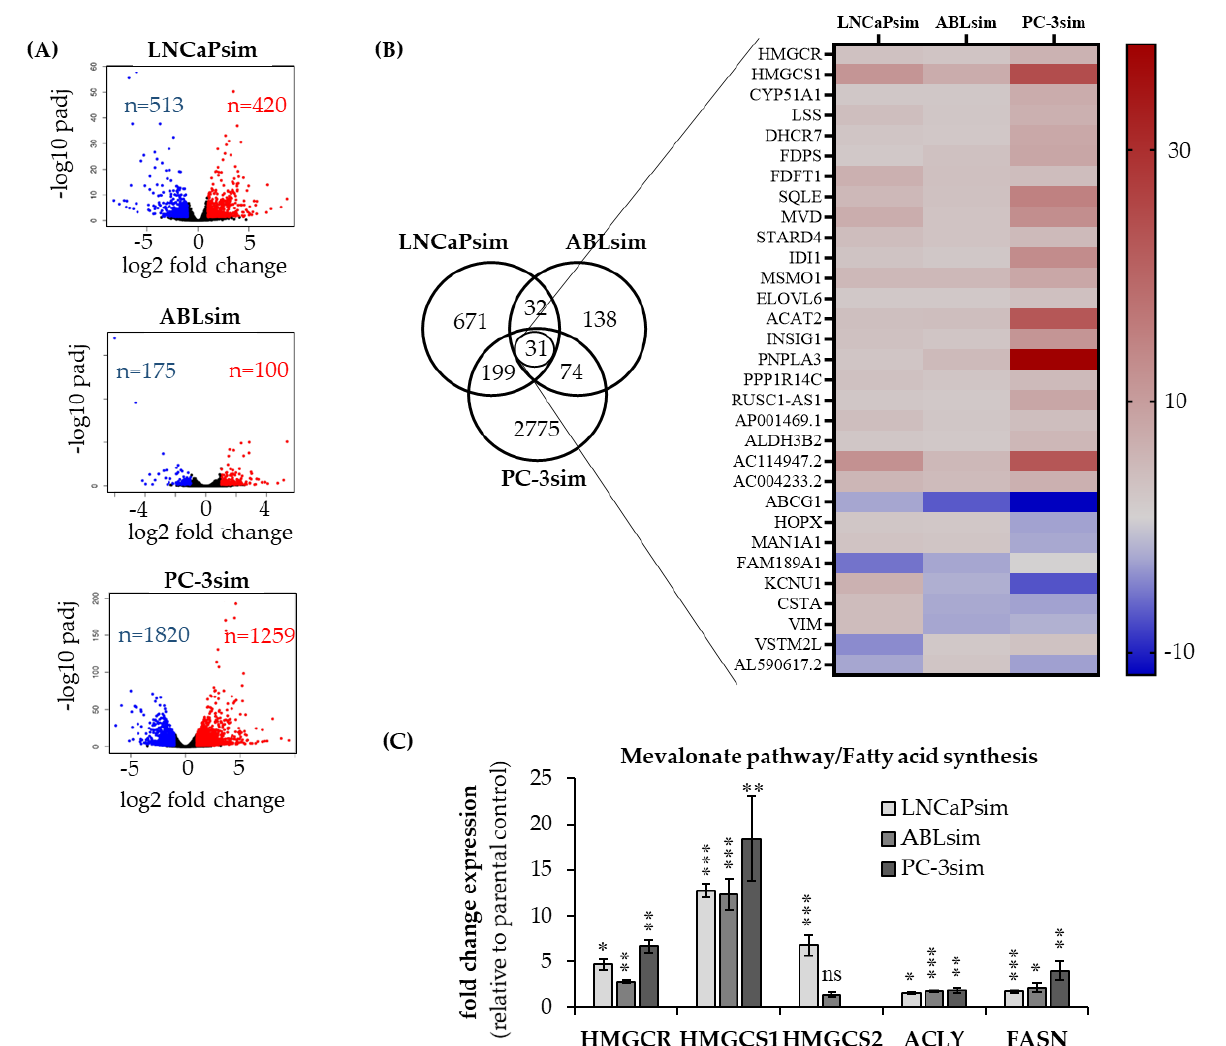
Figure 5. Identification of differentially expressed genes following long-term simvastatin treatment. ( A ) Volcano plot of differentially expressed genes (DEGs) in control and simvastatin (sim)-treated cells. Red points represent upregulated, blue points downregulated genes. Genes without any significant difference are in black. ( B ) Heat map illustrating 31 DEGs in all 3 cell lines following long-term simvastatin treatment. ( C ) Fold change in gene expression in long-term simvastatin-treated cell lines compared to their parental control cells determined by real-time qPCR in 3 different passage numbers of simvastatin-treated cells. Data are represented as mean ± SEM. (* p < 0.05, ** p < 0.01, *** p < 0.001, ns, not significant).